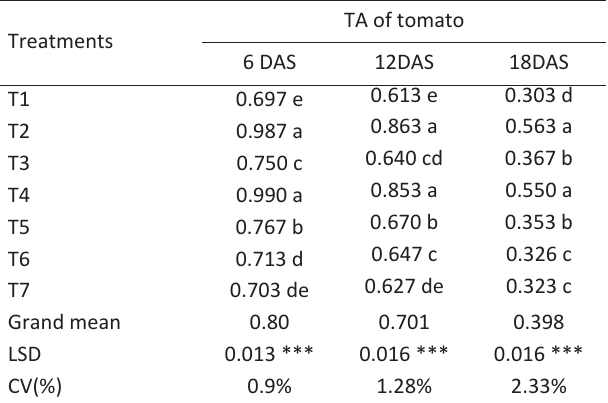
Table 4 ­ Effect of different packaging materials on TA content